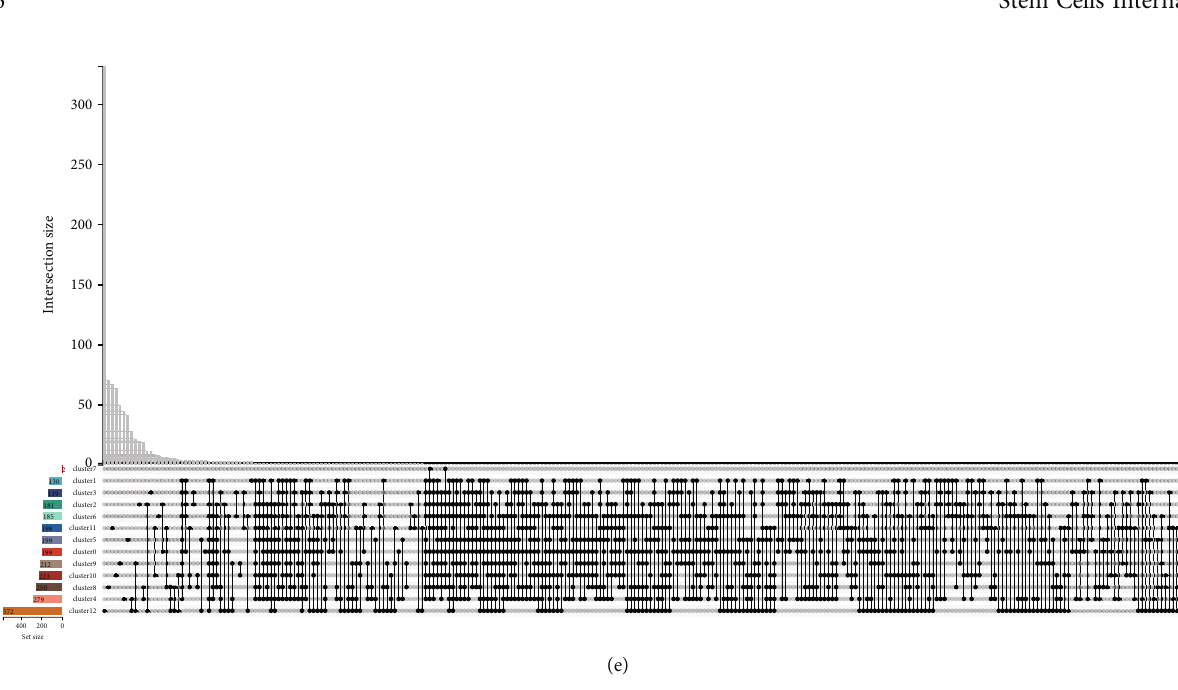
Figure 3: (a, b) Using t -distributed stochastic neighbor embedding, a dimensionality reduction algorithm, cells were grouped into 18 kinds, with each hue representing a di ff erent annotated phenotype for each cluster. (c, d) Timeline of cells and related cell types. (e) A Venn plot of overlap DEGs in each